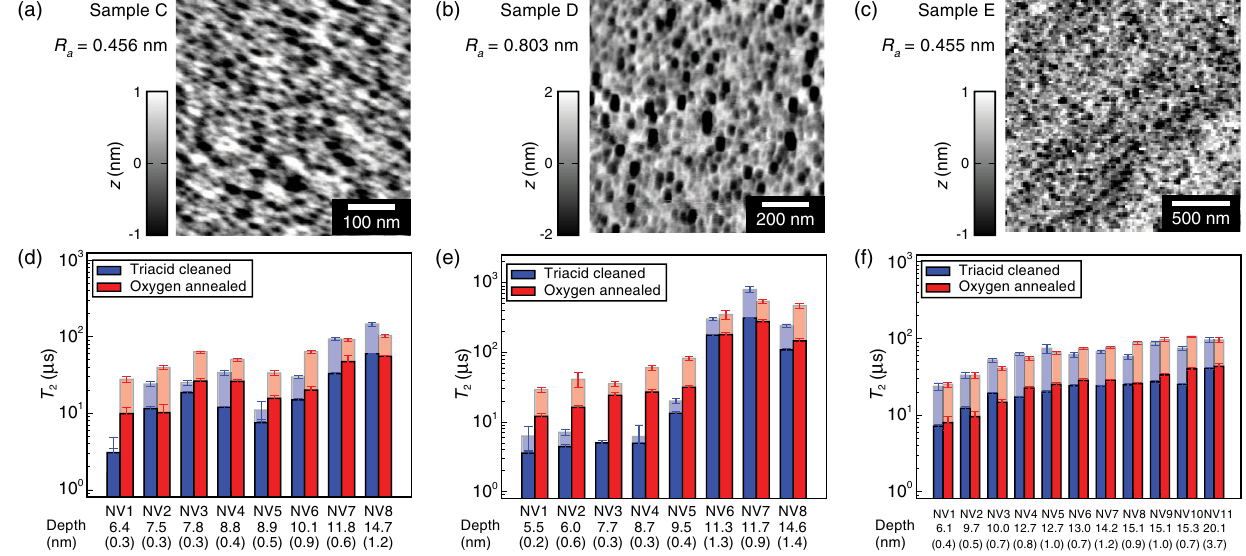
FIG. 9. (a) – (c) AFM images and (d) – (f) NV coherence times T 2 with rougher surface morphologies. The improvement in coherence time after oxygen annealing is less pronounced than that of sample A.